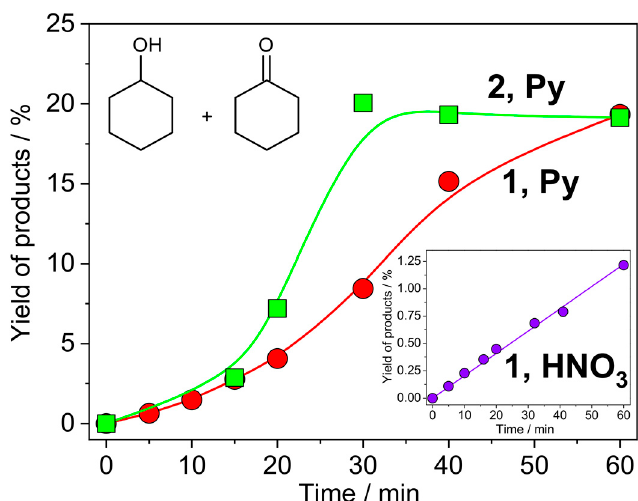
Figure 11. Accumulation of oxygenates (sum of cyclohexanol and cyclohexanone) over time in the oxidation of 0.2 M of cyclohexane with 1.0 M of H 2 O 2 (50% aqueous) in the presence of promoter (1 × 10 − 2 M) catalysed by complex 1 or 2 (1 × 10 − 3 M) in acetonitrile at 50 ◦